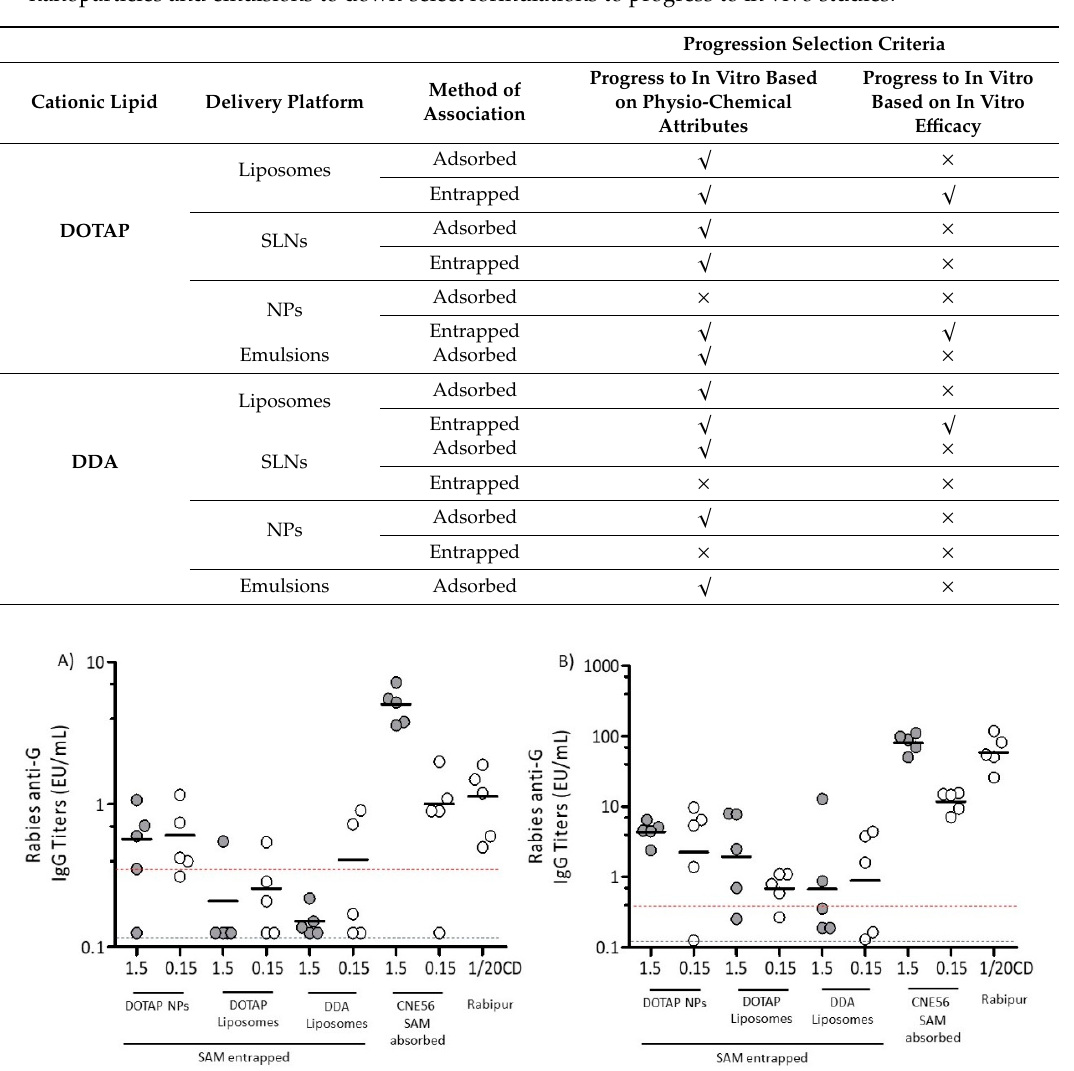
Figure 4. Immunogenicity of SAM-RVG vaccine delivered by different cationic carriers. Groups of ten BALB/c mice were immunized i.m. on days 0 and 28 with either 1.5 or 0.15 µg of self-amplifying RNA encoding the rabies virus G protein formulated in DOTAP polymeric nanoparticles (NPs), DOTAP Liposomes or DDA Liposomes, and compared to the commercial vaccine Rabipur (1/20 of human dose). GSK trademark CNE56 was used as a positive control. Specific IgG titers were measured by enzyme-linked immunosorbent assay (ELISA). For each group, there were 5 samples, each representing data from pools of two mice (depicted as circles), and the geometric mean titers (GMTs) are solid lines. Sera were collected and analyzed ( A ) 4 weeks after the first immunization and ( B ) 2 weeks after the second immunization. Titers < 0.125 EU / mL (dotted blue line) were below the limit of detection, while titers > 0.5 EU / mL (dotted red line) were an indication of protection. Intergroup comparison was analyzed using the one-way analysis of variance (ANOVA) test (Dunnett’s multiple comparison